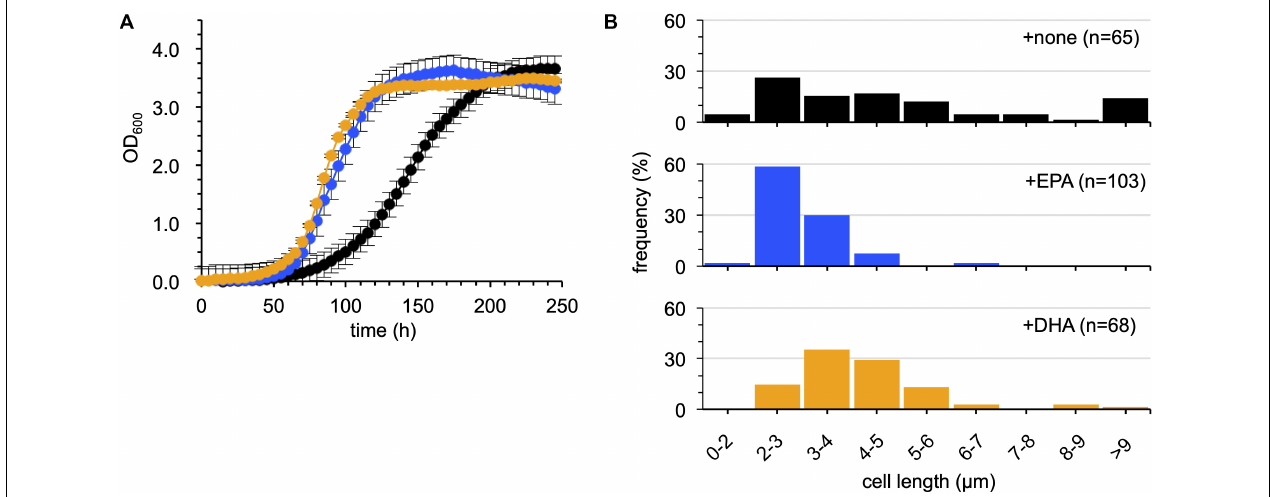
FIGURE 5 | Examination of the effects of EPA and DHA supplementation on the growth of the (cid:49) EPA/ sl_1351 strain. The growth (A) and cell length distribution (B) of non-supplemented (black), EPA-supplemented (blue), and DHA-supplemented (orange) cells are shown. The growth curves were produced according to three independent experiments. The numbers of cells subjected to size measurements are indicated in brackets in each